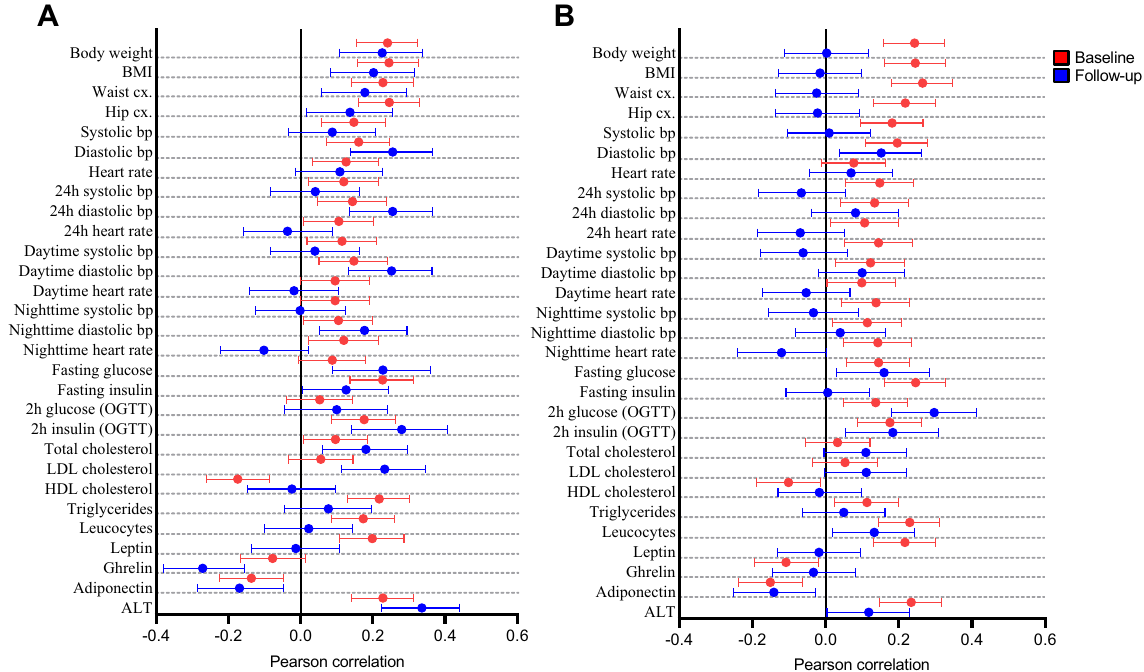
Figure 1. Sex-specific associations of Hb levels with key anthropometric, metabolic and ambulatoric blood pressure (ABP) parameters. Forest plots representing the effect sizes and their 95% confidence intervals for one standard deviation (1-SD) change in key anthropometric measures and metabolic parameters at baseline (red) and at the the 20-year follow-up (blue). ( A ) males, ( B ) females. BMI body mass index, cx circumference, bp blood pressure, OGTT oral glucose tolerance test, LDL low-density lipoprotein, HDL high-density lipoprotein, ALT alanine